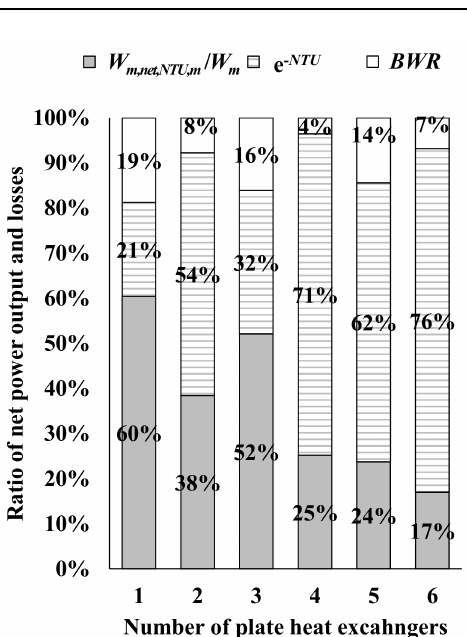
Figure 6. The ratio of net power, loss in the heat exchange process ( e − NTU ), and backwork ratio at the optimum mean velocity of heat source in the plate when T W = 30 ◦ C, T C = 5 ◦ C, c p = 4.0 kJ/kgK and ρ = 1025 kg/m 3